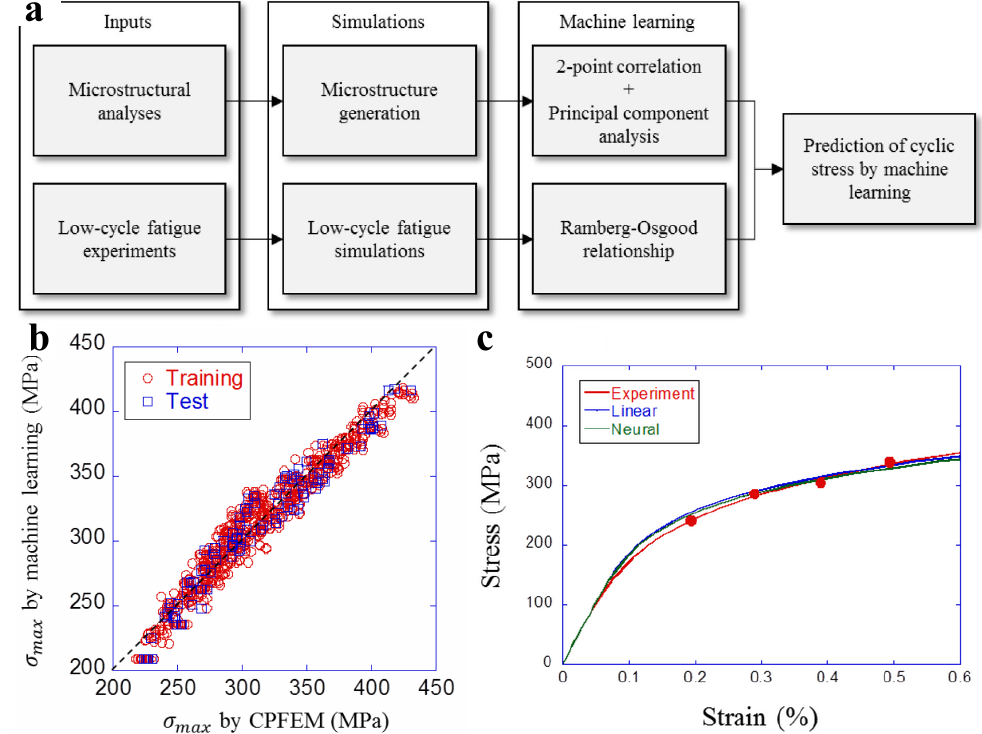
Figure 5. Machine learning to predict stress-strain curves in steel. ( a ) Framework applied by Miyazawa et al. [114] in order to predict the cyclic stress-strain property of dual-phase steels. The approach combines EBSD, mechanical experiments, and FEM simulations of crystal plasticity, to develop a principal component analysis ML model. ( b ) Prediction result of a linear regression model with the best combination of principal components. ( c ) Comparison results between machine learning and experiment for S25C dual-phase steel. Reproduced after [114] based on Creative Commons Attribution